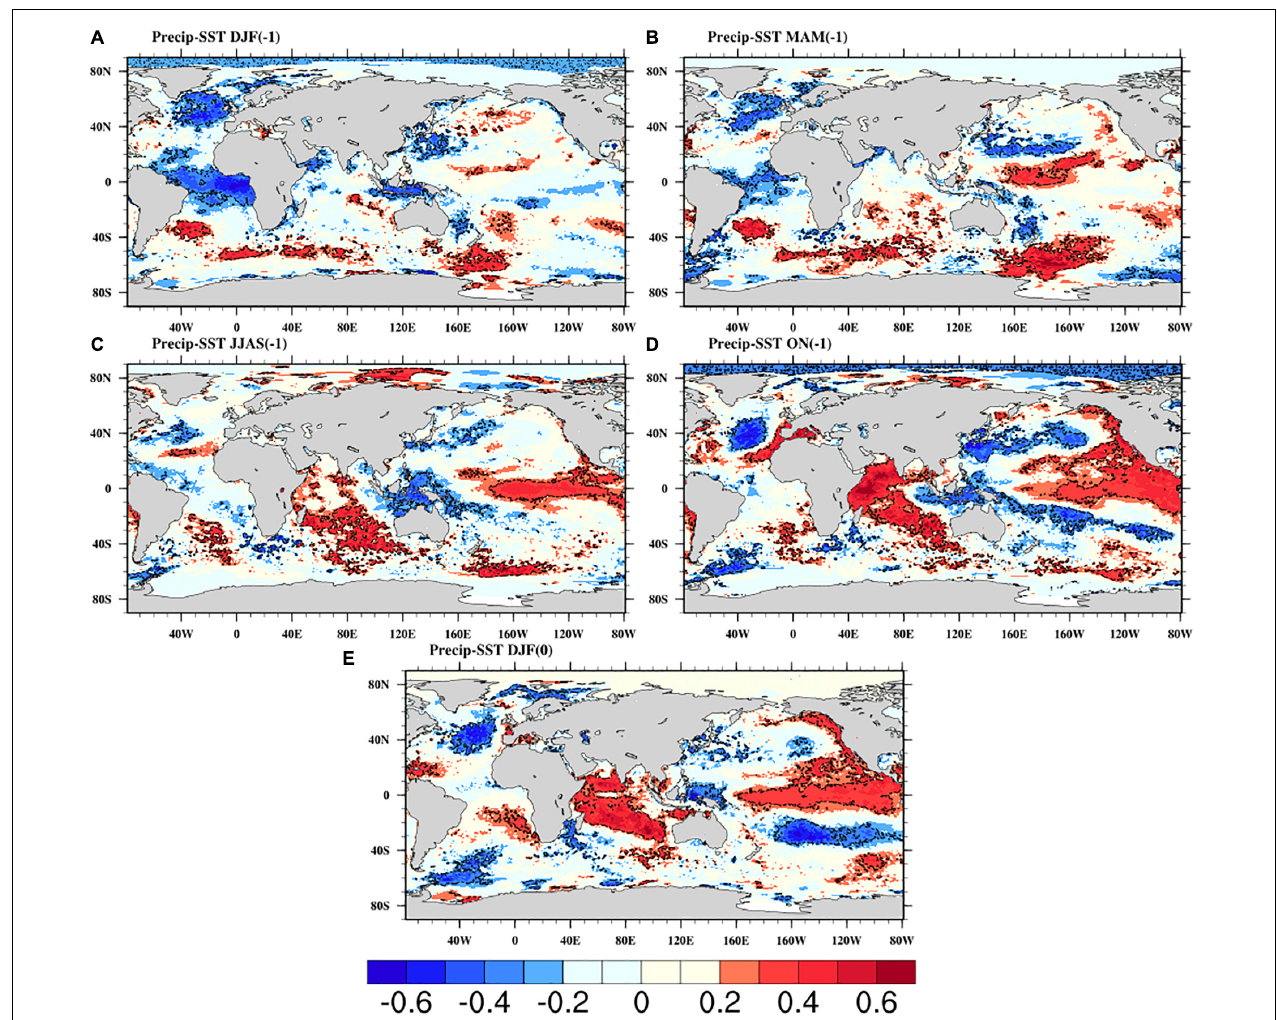
FIGURE 12 | Correlation between averaged winter precipitation and SST during 1987–2015 (A) DJF( − 1), (B) MAM( − 1), (C) JJAS( − 1), (D) ON( − 1), (E) DJF(0), respectively. − 1 and 0 represents lag and corresponding season, respectively. The black dotted contours represent the significance at a 95% confidence